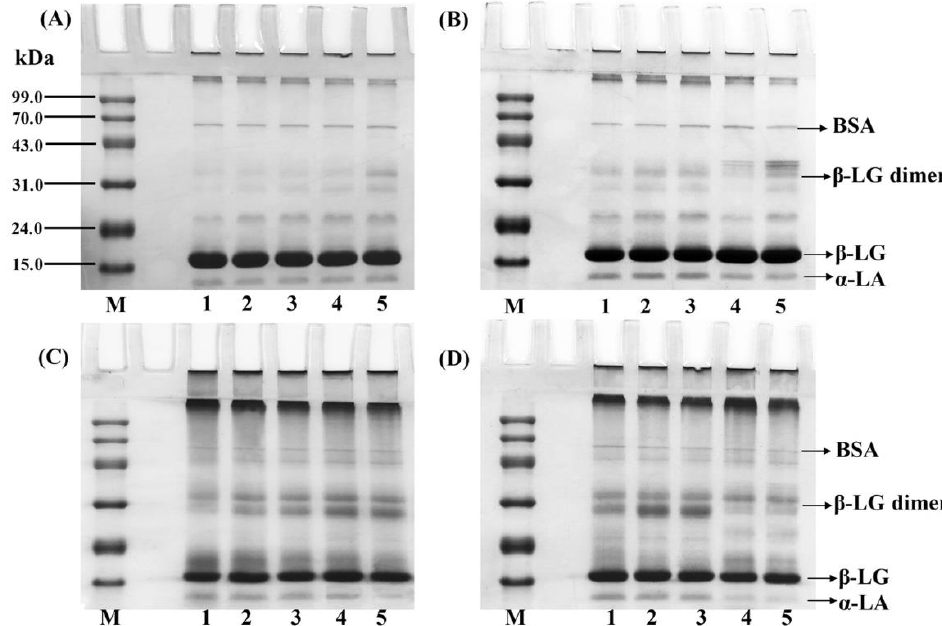
Figure 4. SDS-PAGE of the unadsorbed ( A , B ) and adsorbed proteins ( C , D ) extracted from O/W emulsions oxidized by different levels of HPODE and MDA (Lane M: marker; lanes 1–5: 0, 1, 10, 100, and 1000 µ mol/L emulsion) after 48 h incubation.